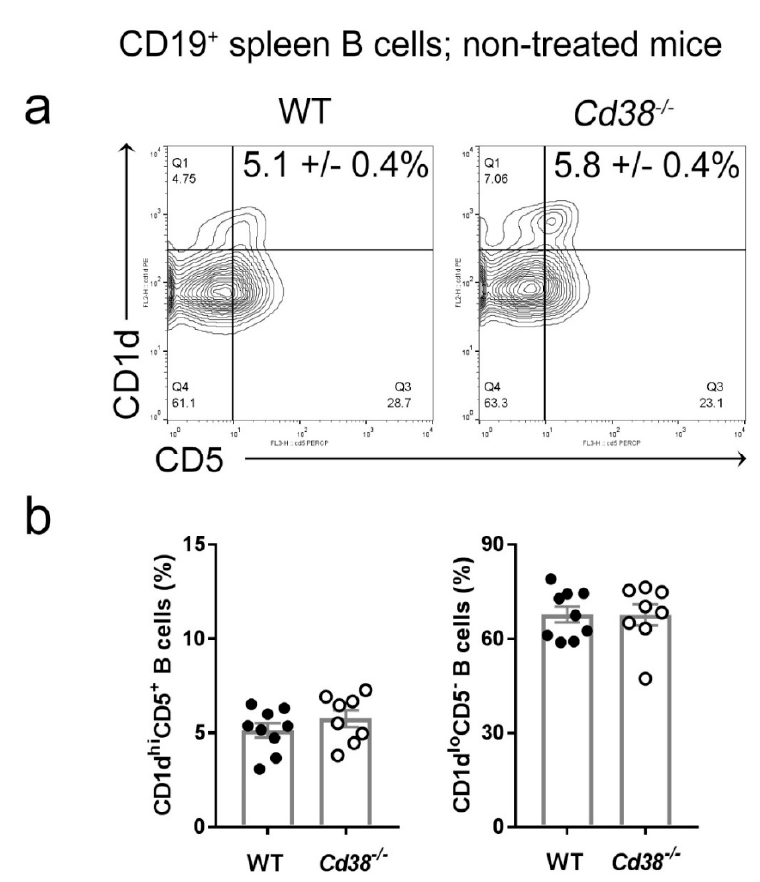
Figure 1. Similar proportion of splenic CD1d hi CD5 + B cells in naïve Cd38 − / − and WT mice. Spleen cells were stained for cell surface CD1d, CD5, CD38, and CD19 as described in Material and Methods. Gating strategy is shown in Figure S1. ( a ) Representative contour-plots of CD1d and CD5 expression by CD19 + B cells from WT and Cd38 − / − mice. Q1–Q4 quadrants show the frequencies of the four major B cell subsets. The mean frequencies ± SEM of the CD1d hi CD5 + cells are highlighted. ( b ) Frequencies ± SEM of the CD1d hi CD5 + (left) and CD1d lo CD5 − (right) B cells. Bars represent the mean frequencies and dots represent the individual values per mouse. Graph summarizes the results from nine independent experiments with a total of nine WT mice and eight Cd38 − / − mice.